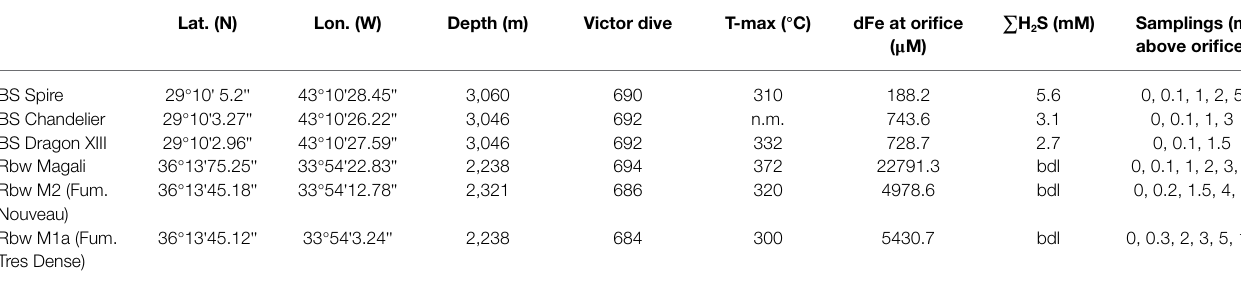
TABLE 1 | General sampling information on vent fluids from Broken Spur (BS) and Rainbow (Rbw). Lat.